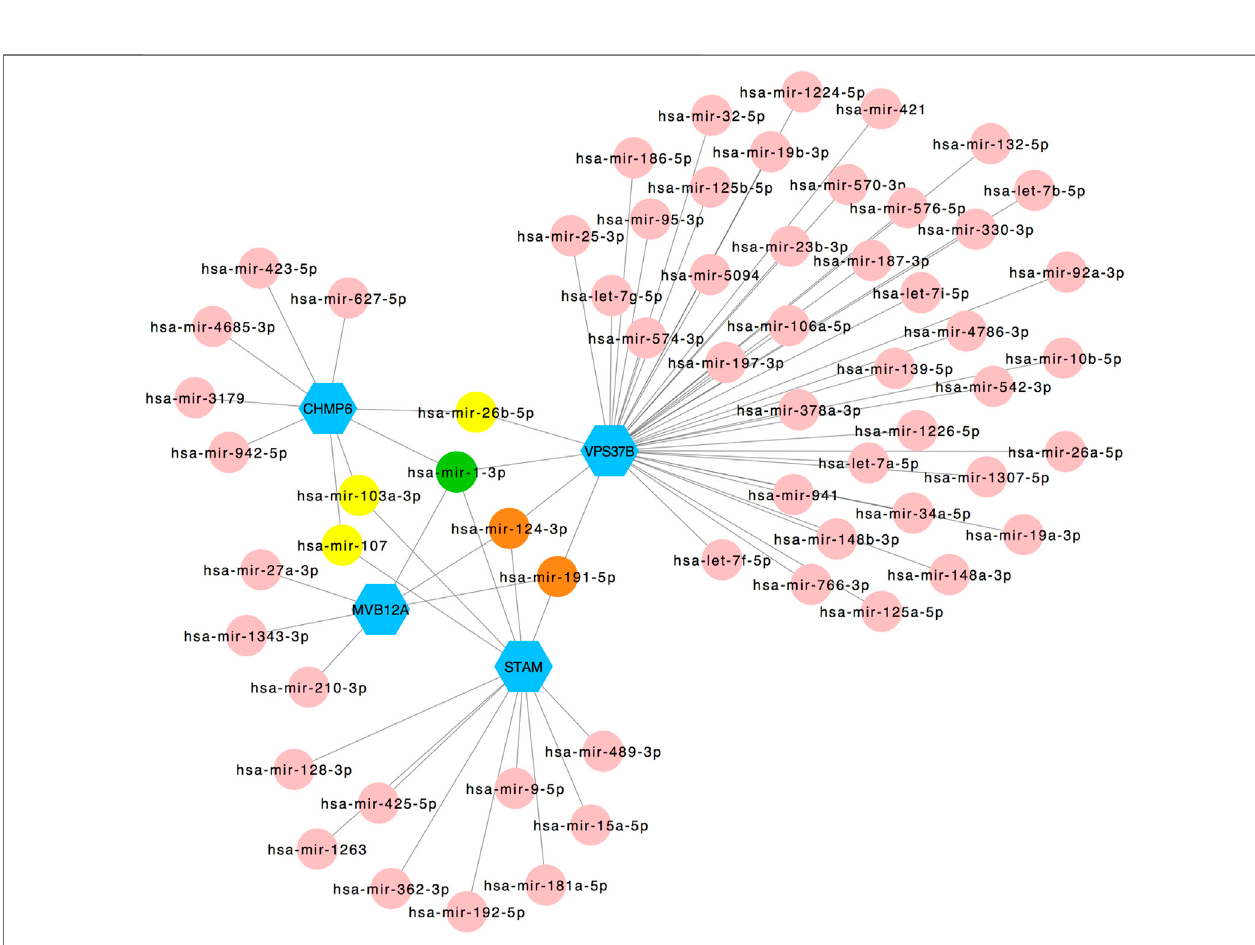
FIGURE 6 | Regulatory interaction network of gene-miRNA was identi fi ed using the NetworkAnalyst tool. Genes are shown in blue; miRNAs are shown in pink; miRNAs targeting two genes are shown in yellow; miRNAs targeting three genes are shown in orange; miRNAs targeting four genes are shown in green.